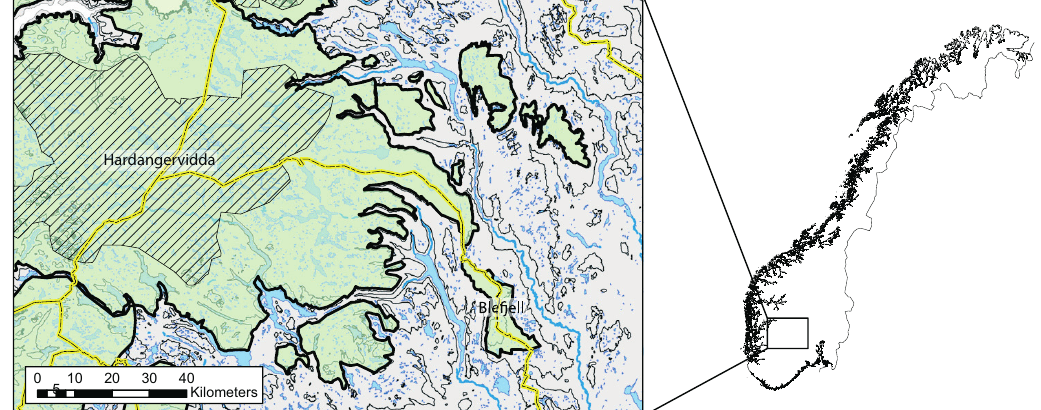
Fig. 1. The location of the study areas Hardangervidda and Blefjell delineated by the 1000 m contour line. The hatched area illustrates Hardangervidda national